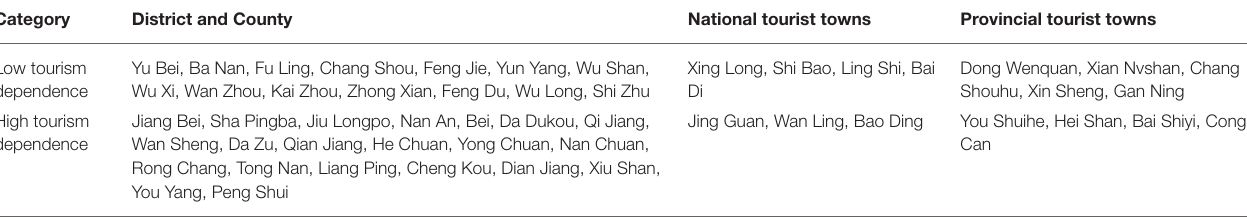
TABLE 5 | Tourism dependence of 38 districts and counties in Chongqing.